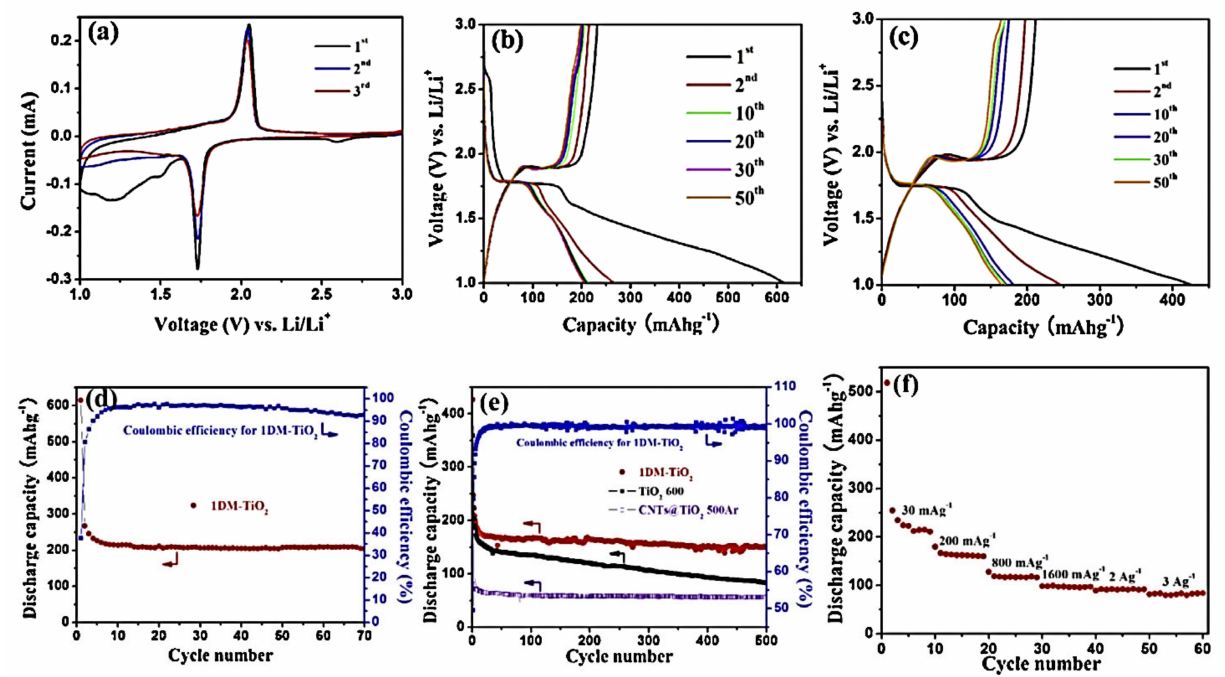
Figure 8. ( a ) The CV diagram. ( b , c ) The charge/discharge profiles at 30 mA g − 1 and 200 mA g − 1 within 1 V and 3 V. ( d ) The cycling performance and Columbic efficiency of 1DMA-TiO 2 at 30 mA g − 1 between 1.0 V and 3.0 V. ( e ) The comparative cycling performance between different samples and Columbic efficiency at 200 mA g − 1 between 1.0 V and 3.0 V. ( f ) The rate capabilities of 1DM-TiO 2 . Reprinted with permission from Ref. [69]. Copyright 2014 Elsevier.